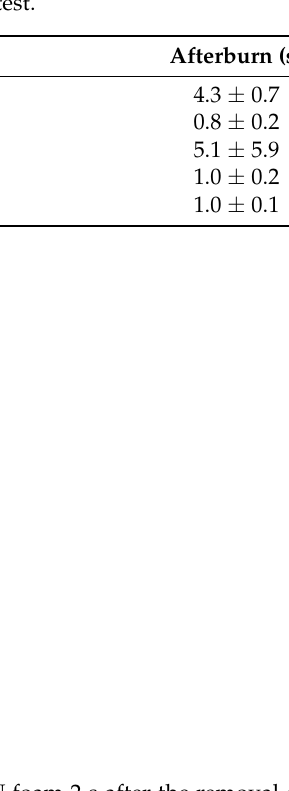
Figure 6. ( Top ) commercial polyurethane foam and NIPU foam 2 s after the removal of a butane torch flame. ( Bottom ) SEM images of both foams’ torched face following torch